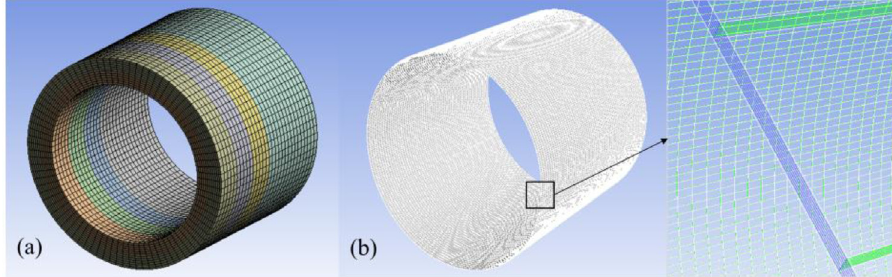
Fig. 4. Mesh model of (a) Bush and (b) Water fi lm.